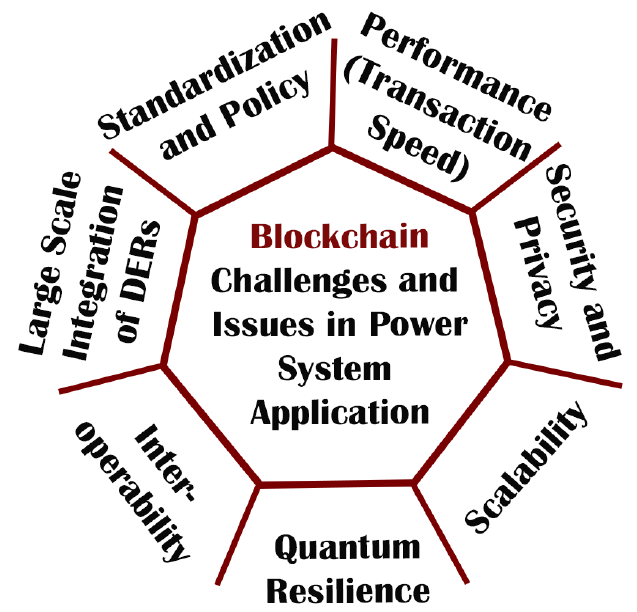
Figure 7. Blockchain challenges and issues in power system application.